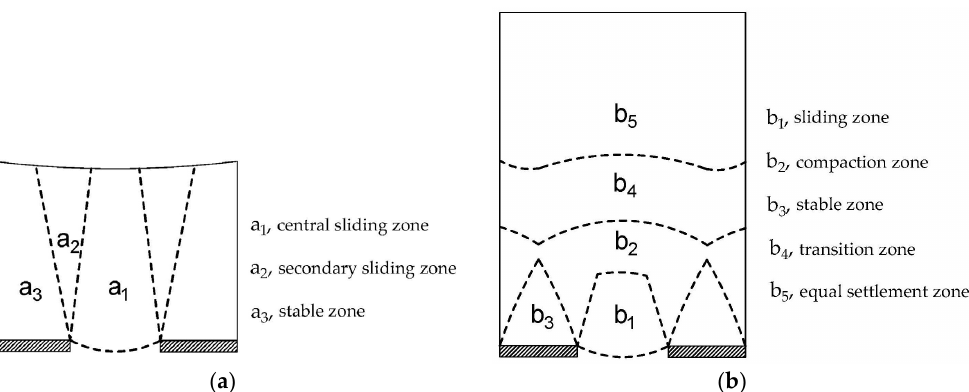
Figure 14. Schematic diagram of area division in the embankment. ( a ) Low embankment height, ( b ) Figure 10. Three-dimensional finite element model of the pile-supported reinforced High embankment height.